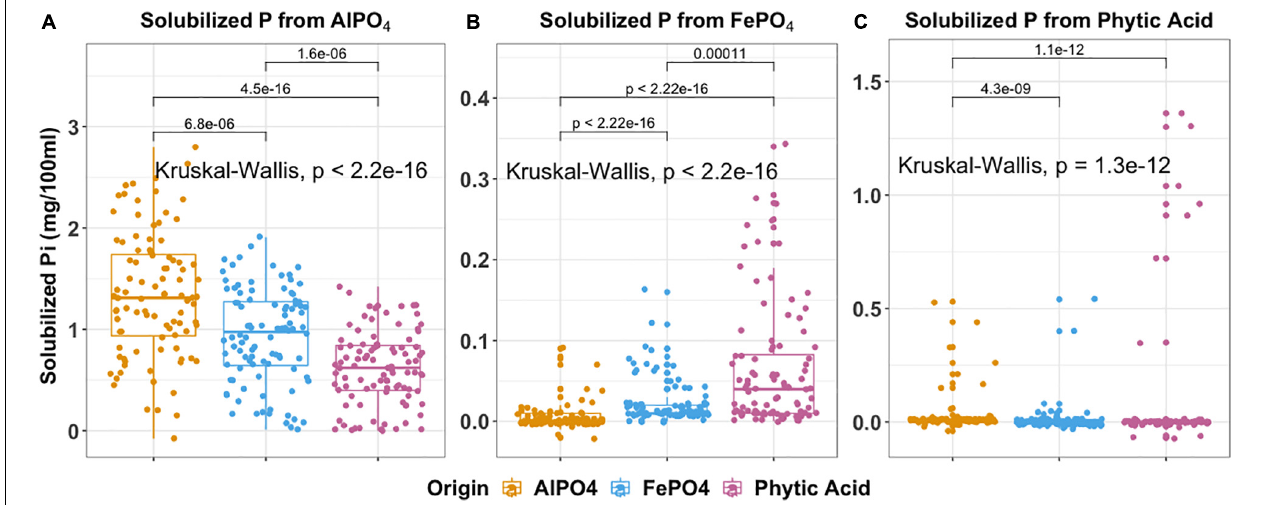
FIGURE 6 | Boxplot indicates P solubilization ability of 288 isolates grouped by the isolation medium of origin. (A) aluminum phosphate solubilization (B) iron phosphate solubilization (C) phytic acid solubilization. In each box plot, a point denotes a single ES isolate. The top and bottom of each box represent the 25th and 75th percentiles, the horizontal line inside each box represents the median and the whiskers represent the range of the points excluding outliers. Kruskal-Wallis was used to compare the differences in P solubilization between bacteria obtained using different isolation media. The Mann-Whitney-Wilcoxon was used to conduct pairwise post hoc